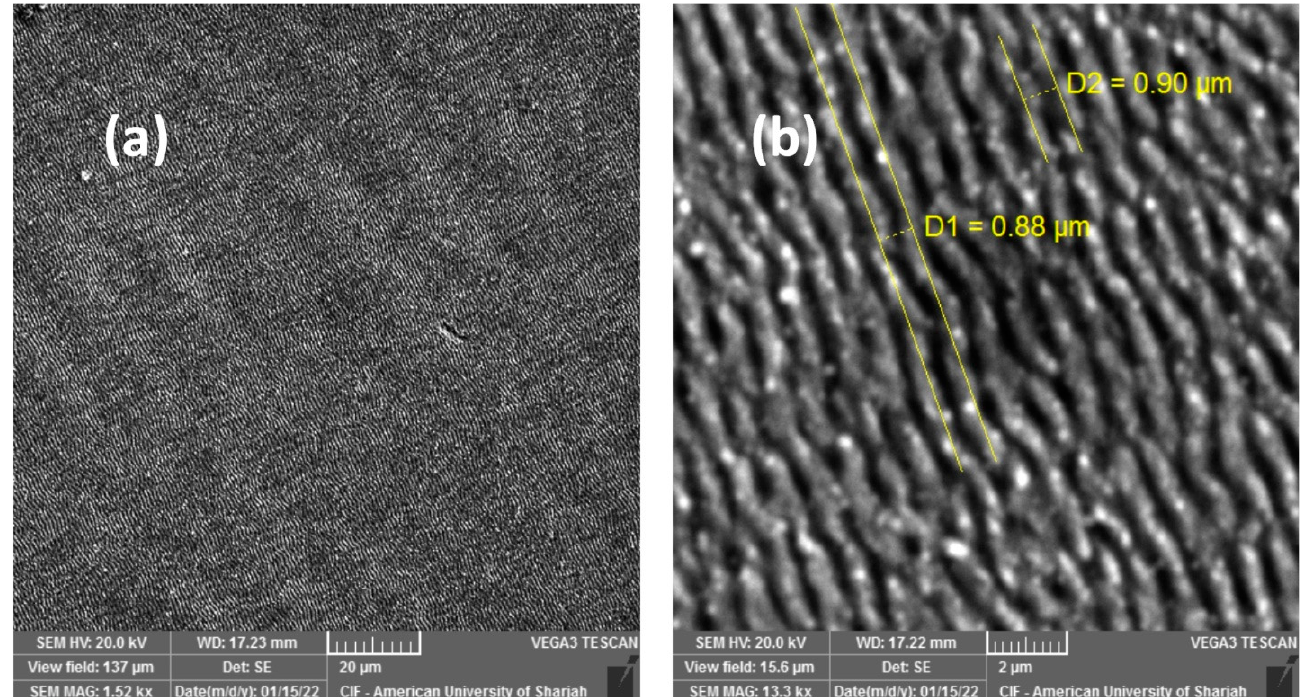
Figure 3. SEM micrographs at ( a ) 1.5 kx and ( b ) 13.3 kx magnifications of Mo-1.5/MS obtained after laser-scanning the as-deposited Mo/MS with 40 fs pulses of 1.5 J/cm 2 fluence and 50 kHz repetition rate.